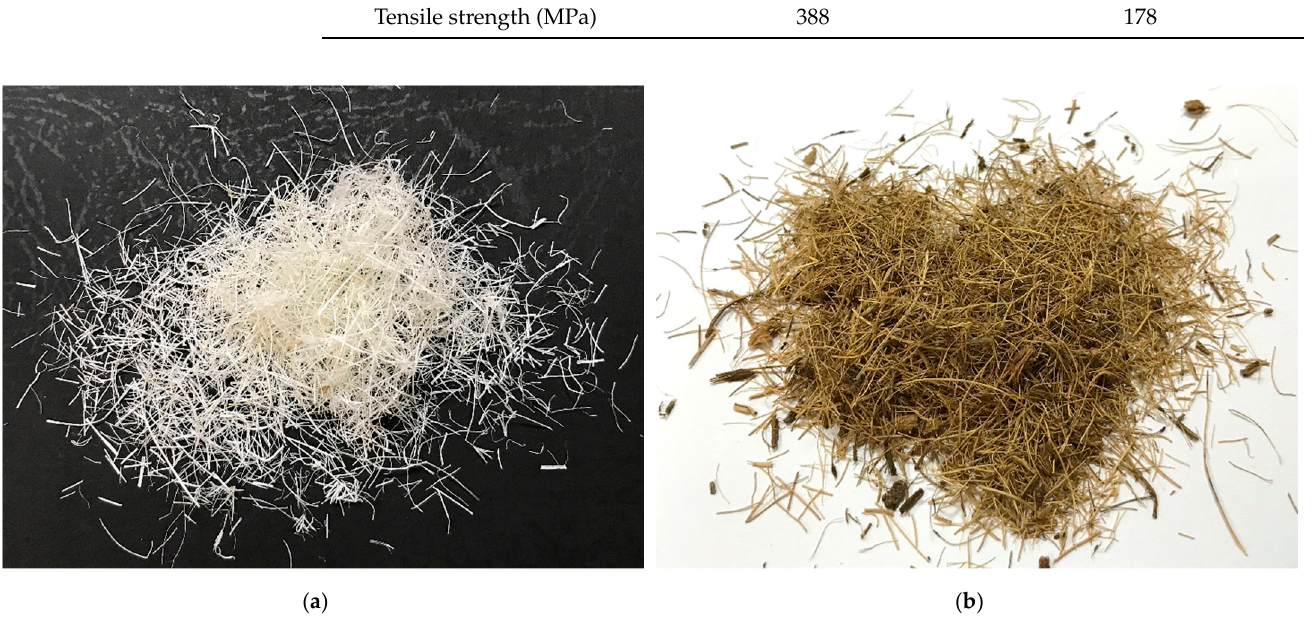
Figure 1. General view of fibers: ( a ) SF; and ( b ) CF.